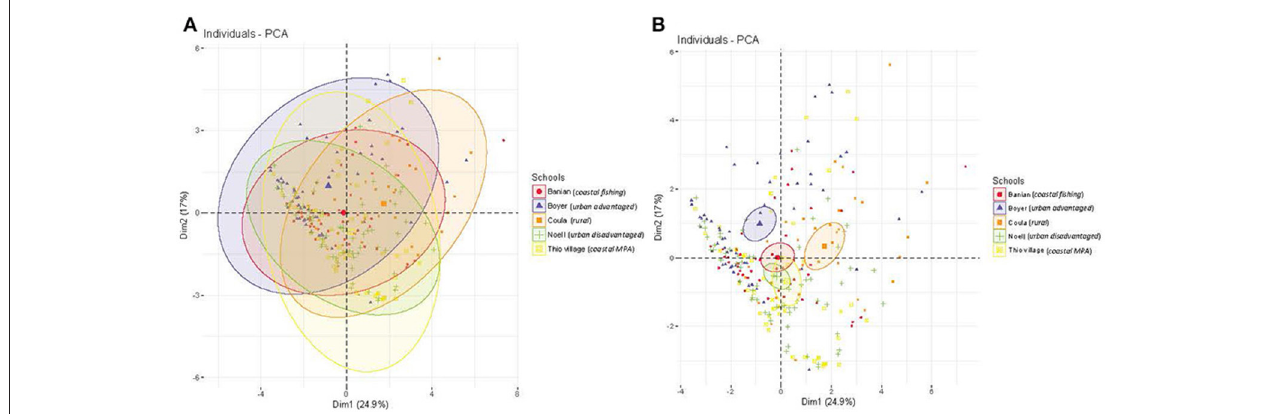
FIGURE 3 | Analysis of the 248 drawings and 16 quantitative variables with Principal Component Analysis (PCA) (see Table 3 for the listing of the variables). (A) Individuals (drawings) with the ellipses delimiting 95% of the individuals of each drawing’s school: Banian (coastal area within a large fishing community, in red), Boyer (socially advantaged urban neighborhood, in purple), Coula (rural environment, in orange), Noell (less advantaged urban neighborhood, in green) and Thio village (coastal area close to a marine reserve, in yellow). (B) Individuals (drawings) and barycenter of the clouds of points with their confidence interval (confidence ellipse).